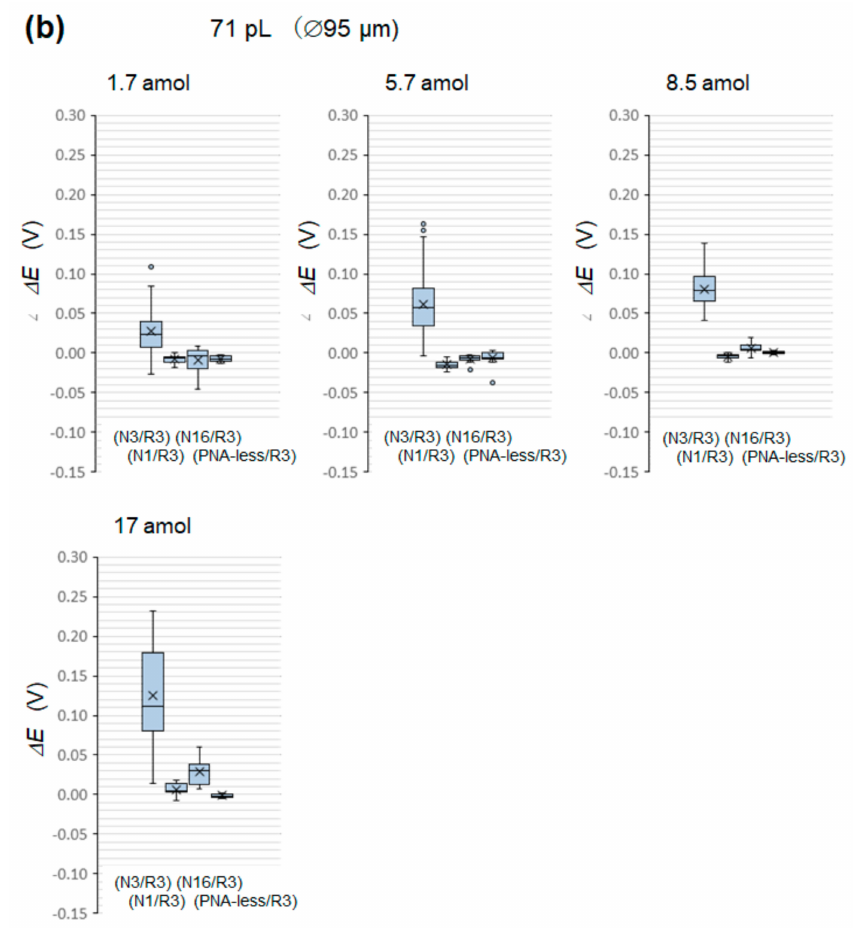
Figure 6. Boxplots of ∆ E detection sensitivity data for ( a ) 35 pL ( ∅ 67 µ m) and ( b ) 71 pL ( ∅ 95 µ m) at varying molar amounts. In each box plot, (N3 / R3) indicates 75 pcs of data of a complementary system, (N1 / R3) and (N16 / R3) each refer to 15 pcs of data of noncomplementary systems, and (PNA-less / R3) indicates 15 pcs of data of the reference system (to identify the occurrence of the chemisorption of miRNA onto